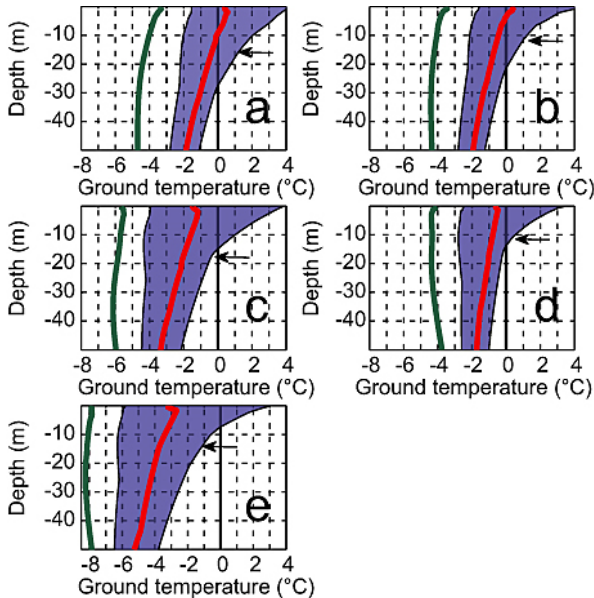
Fig. 6. Predicted future evolution of permafrost temperatures. (a) Kapp L. BH1, (b) Kapp L. BH2, (c) Janssonhaugen, (d) Endalen, (e) Gruvefjellet. The green lines represent the start conditions, ei- ther measured (Janssonhaugen) or derived from the historic mod- elling based on instrumental data from January 2000 (all other sites). The red line is the median of all scenario results, the shaded polygon denotes minimum and maximum GT from the scenario runs. The ZAA is indicated by arrows and is situated between 10 and 20